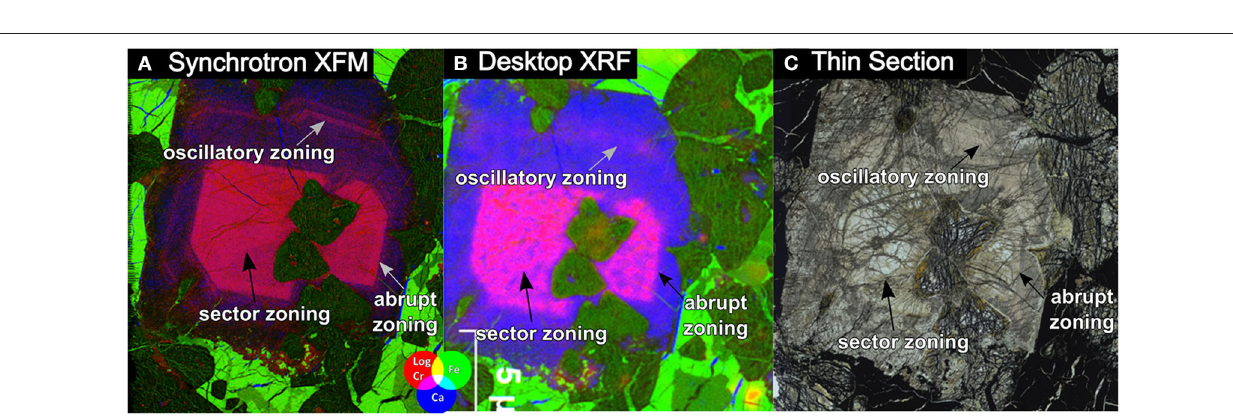
FIGURE 12 | Sample KU30024 imaged by (A) µ XRF on the Australian synchrotron, (B) a Bruker desktop microbeam XRF mapper—M4 Tornado TM , (C) and plane polarized light image of the thin section. The abrupt zoning can be observed very well with a desktop XRF system and can sometimes be distinguished in thin section. The sector zoning is also visible in thin